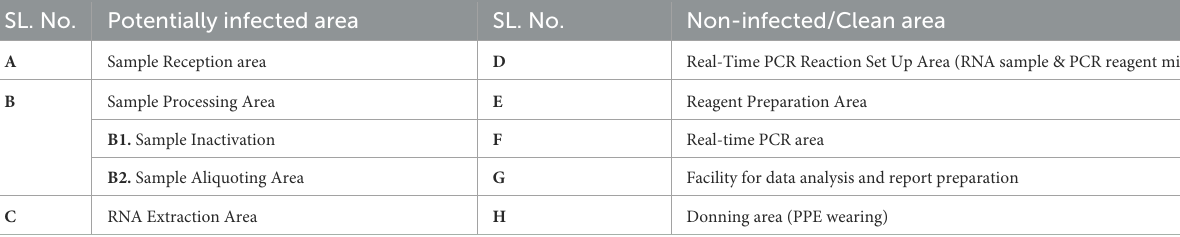
TABLE 1 Potentially infected and non-infected or clean areas of HTVDL-NICPR, Noida. SL.